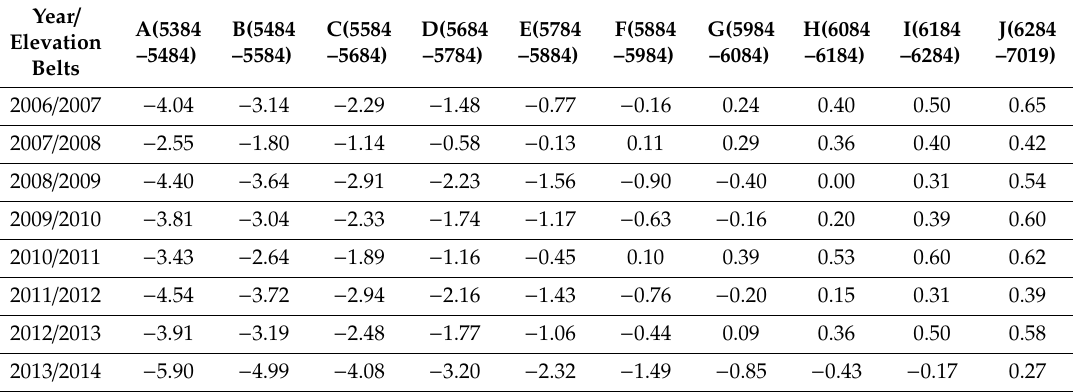
Table 6. Elevation wise simulated GMB of the Nam Co